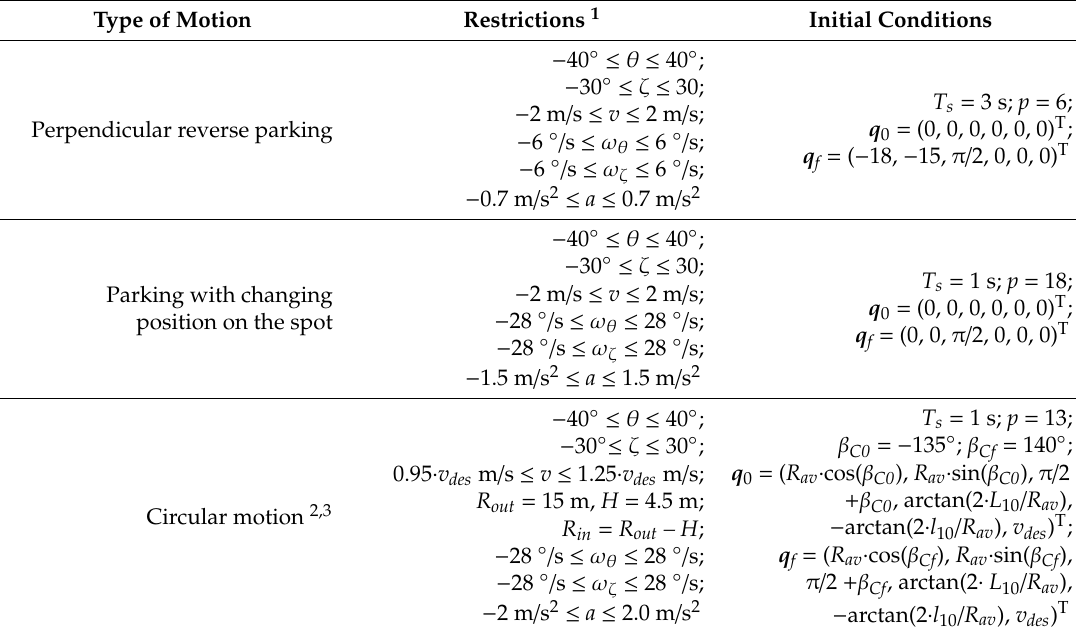
Table 2. Restrictions and initial conditions for simulating long single trucks.